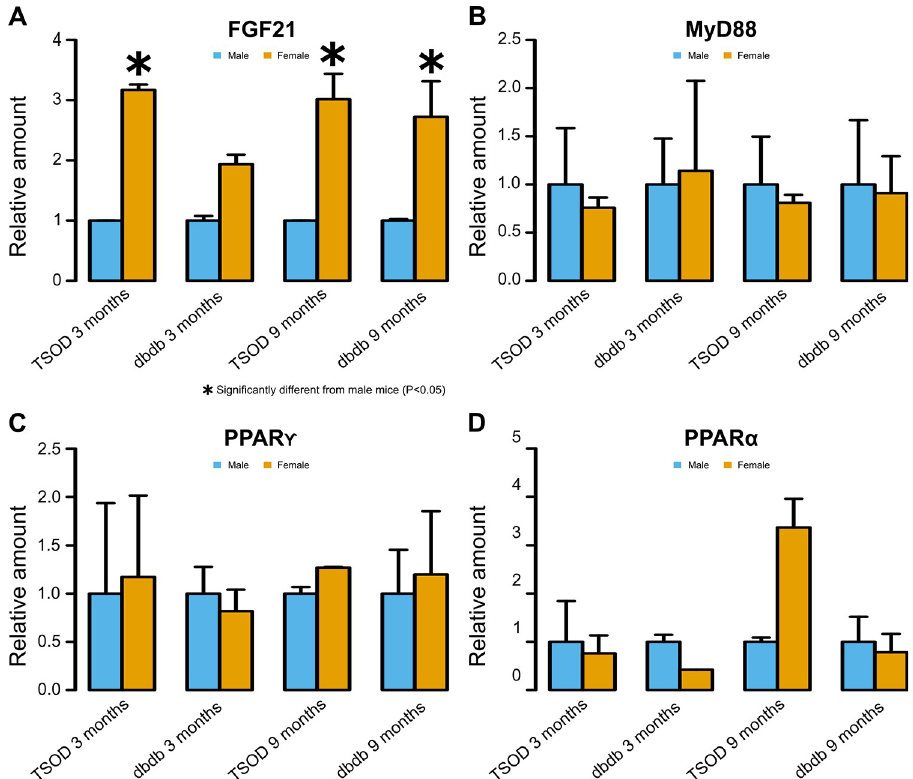
Fig 7. Hepatic expression levels of genes determined by real-time reverse transcription polymerase chain reaction. A) The expression levels of fibroblast growth factor (FGF)21 mRNA are significantly higher in female TSOD mice than males at 3 months and significantly higher in female TSOD and db/db mice than males at 9 months (two-tailed t-test). B-D) For the expression levels of myeloid differentiation primary response (MYD)88 , peroxisome proliferator-activated receptor (PPAR) α , and PPAR γ , significant sex differences are not observed in both strains and age groups (two-tailed t-